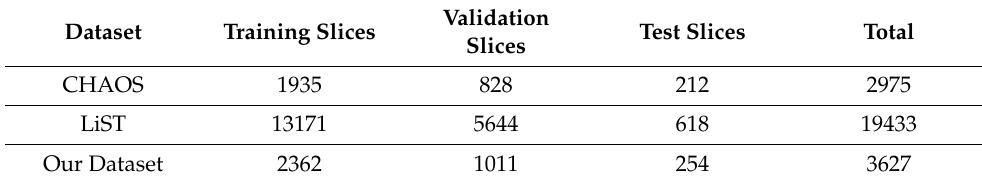
Table 2. Distribution of images in